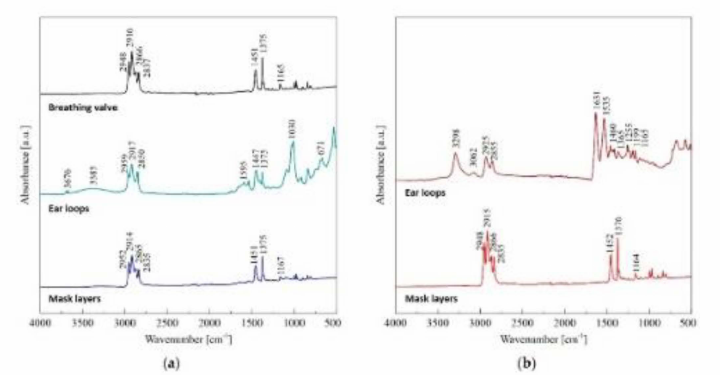
Figure 2. FT-IR spectra profiles of different parts in ( a ) N95/KN95-like multi-layer respirator with an FFP3 breathing valve and ( b ) three-layer melt-blown mask. Reproduced with permission from Ref. [54]. Copyright 2021 The Authors. Published by